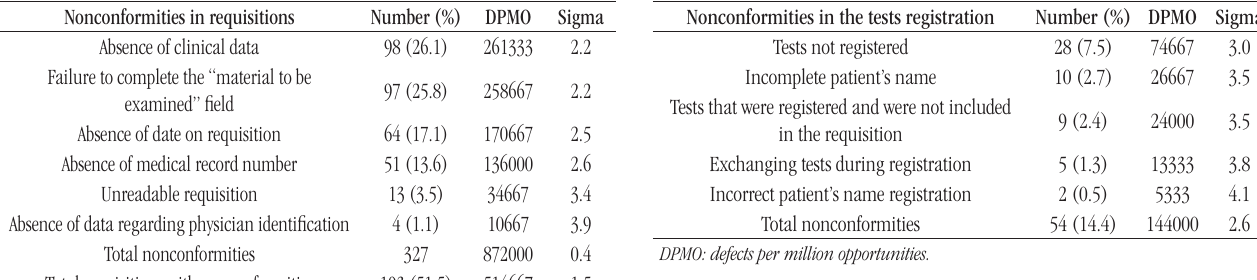
taBLE 1 – Nonconformities observed in the requisitions of